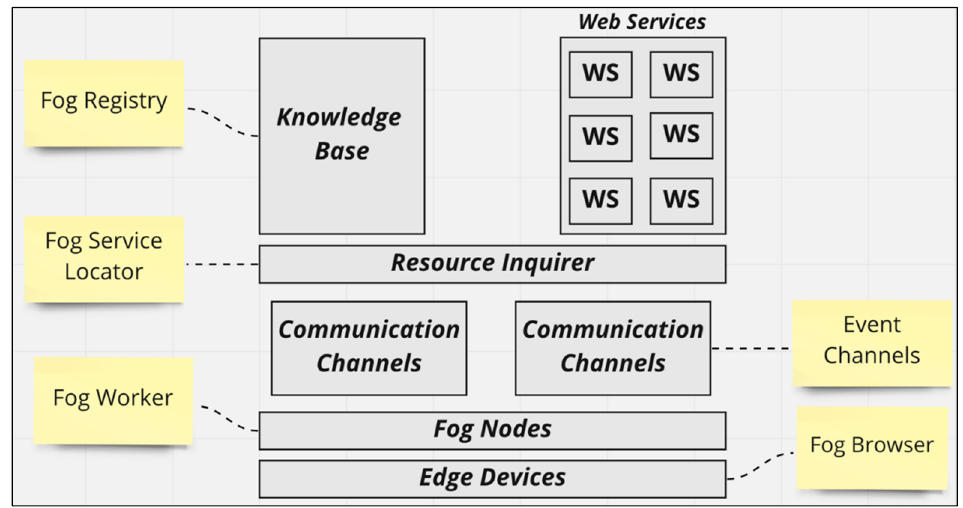
Figure 4. High-level architecture of the fog-based CDN.